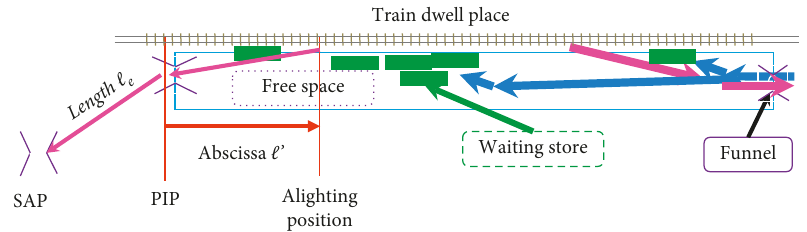
Figure 1: Platform